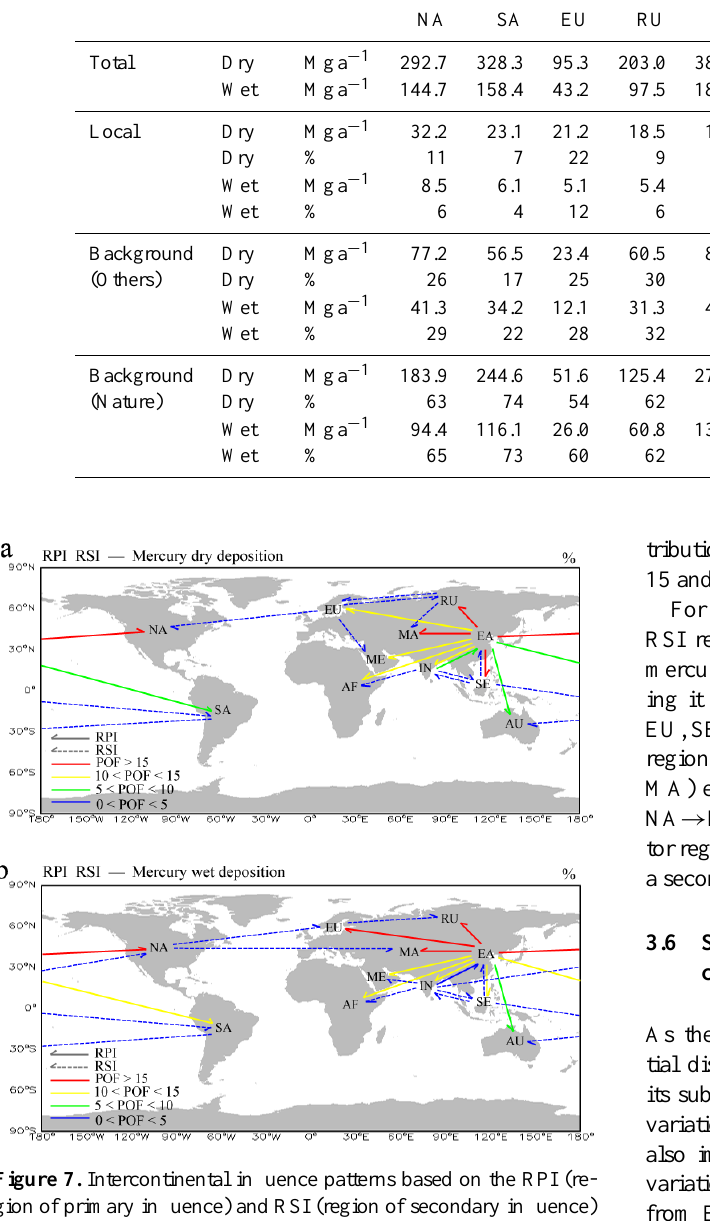
Figure 7. Intercontinental influence patterns based on the RPI (re- gion of primary influence) and RSI (region of secondary influence) for mercury deposition: (a) mercury dry deposition; (b) mercury wet deposition. The arrows and colors are defined same as Fig.